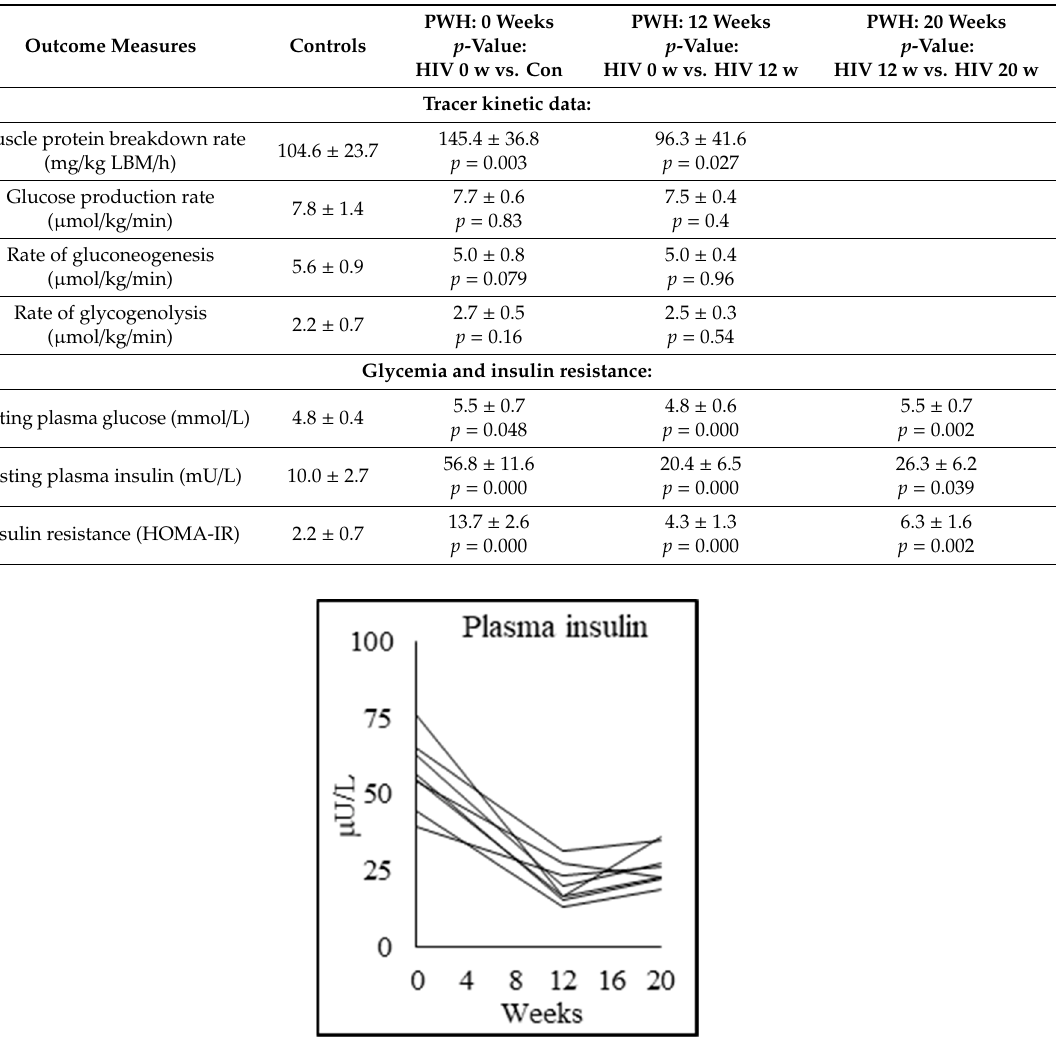
Table 4. Tracer kinetic data and glycemic indices.